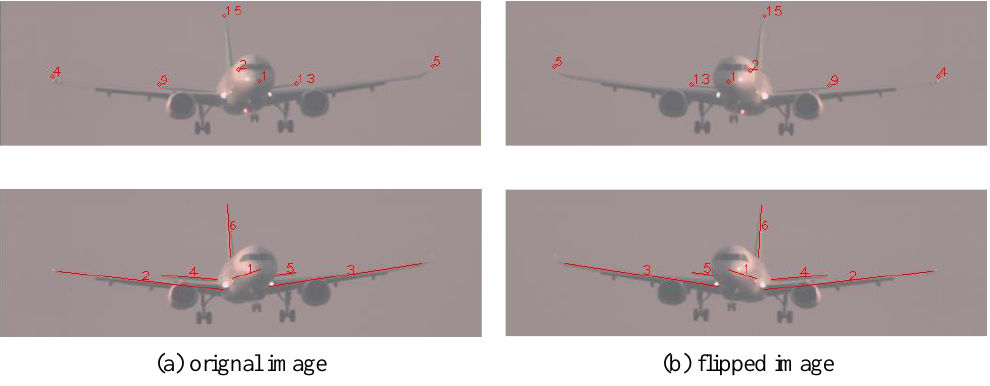
Figure 12. Flipping the image horizontally may cause confusion. Original image ( a ) and flipped image ( b ).